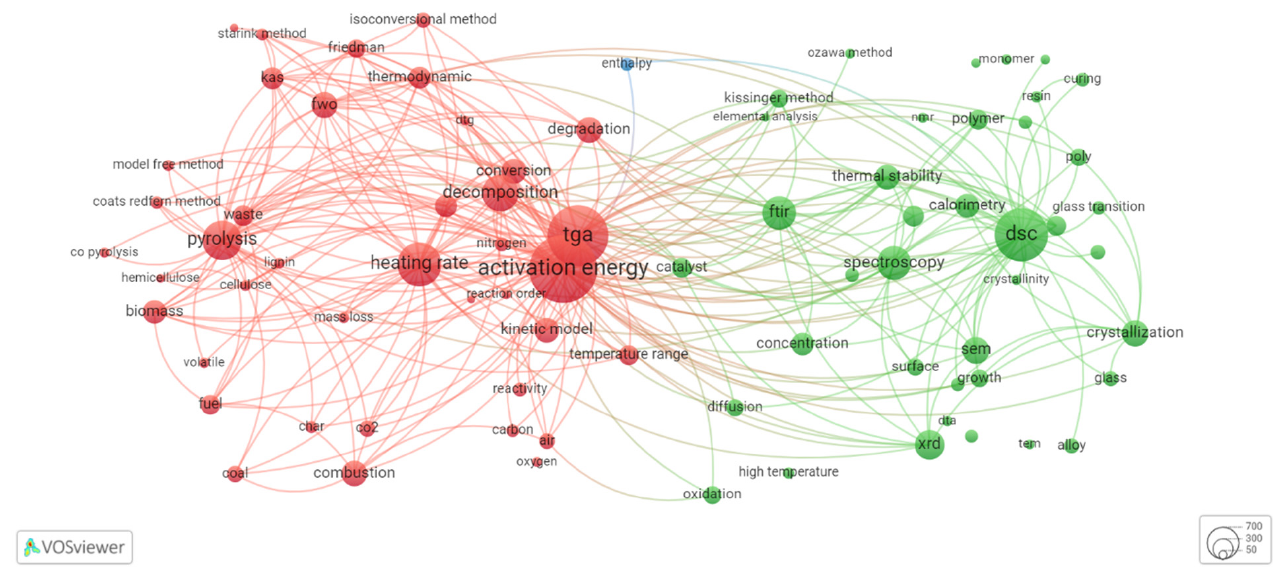
Figure 4. Co ‐ occurrence of keywords extracted from thermokinetic papers published at 2021 (89 keywords occurred at least 30 times in the title and abstract).